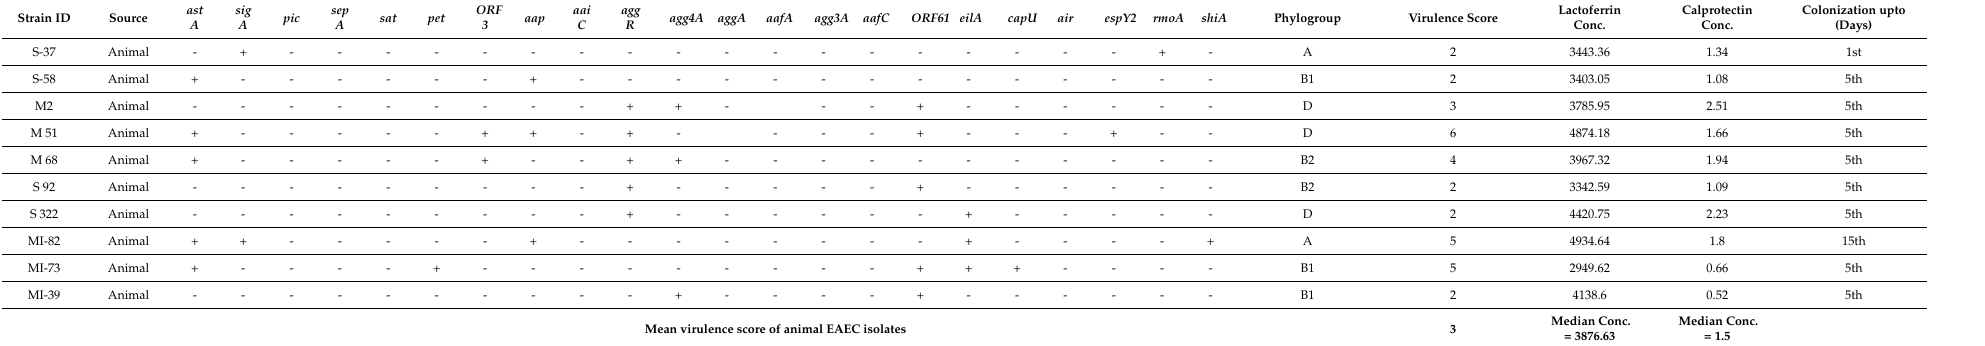
Table 3. The virulence genes’ content and phylogroups. Inflammatory markers and colonization from animal sources.